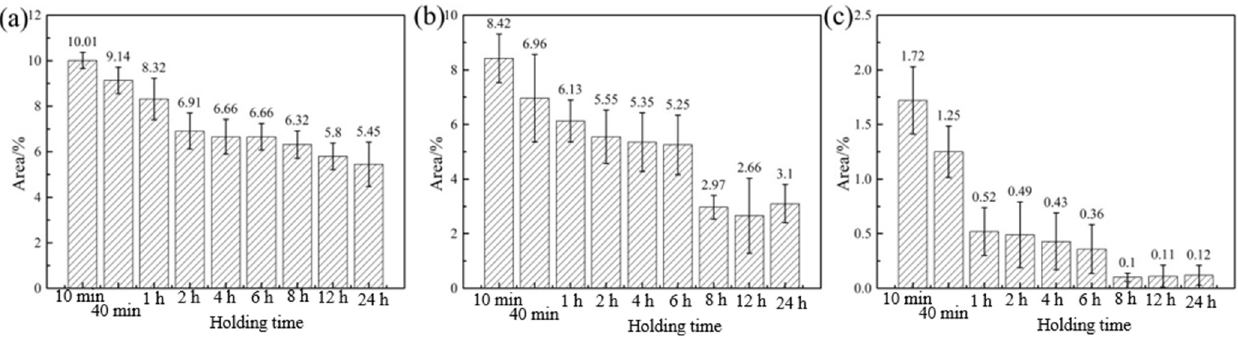
Figure 6. The BSE photographs of different heat treatment states. Figure 7. The volume fraction of the second phase against holding time at ( a ) 470 °C, ( b ) 500 °C, and ( c ) 530 °C.